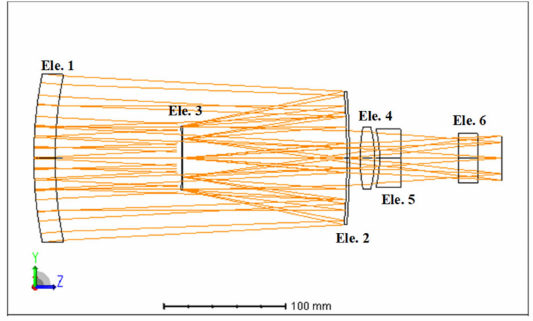
Figure 6. Layout of the initial optical system.